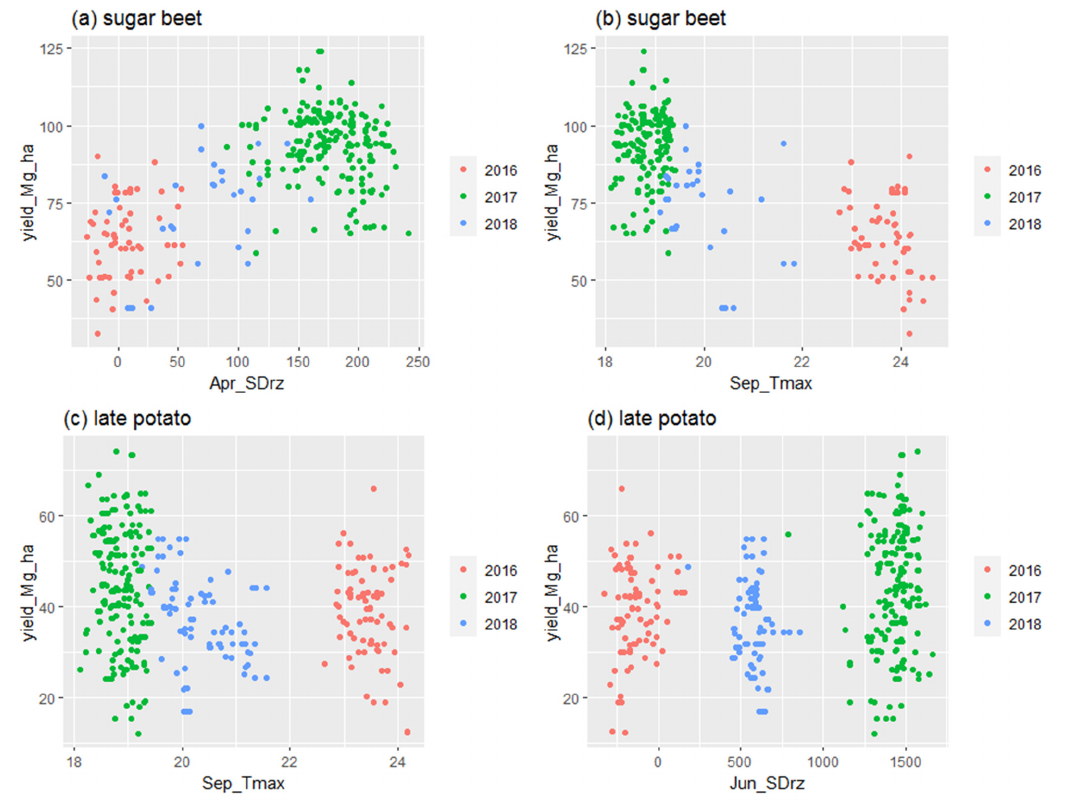
Figure 6. ( a ) Scatterplot: root-zone soil water depletion in April versus sugar-beet crop yield, ( b ) scatterplot: maximum temperature in September versus sugar-beet crop yield, ( c ) scatterplot: maximum temperature in September versus late-potato crop yield, and ( d ) scatterplot: root-zone soil water depletion in June versus late potato crop yield.